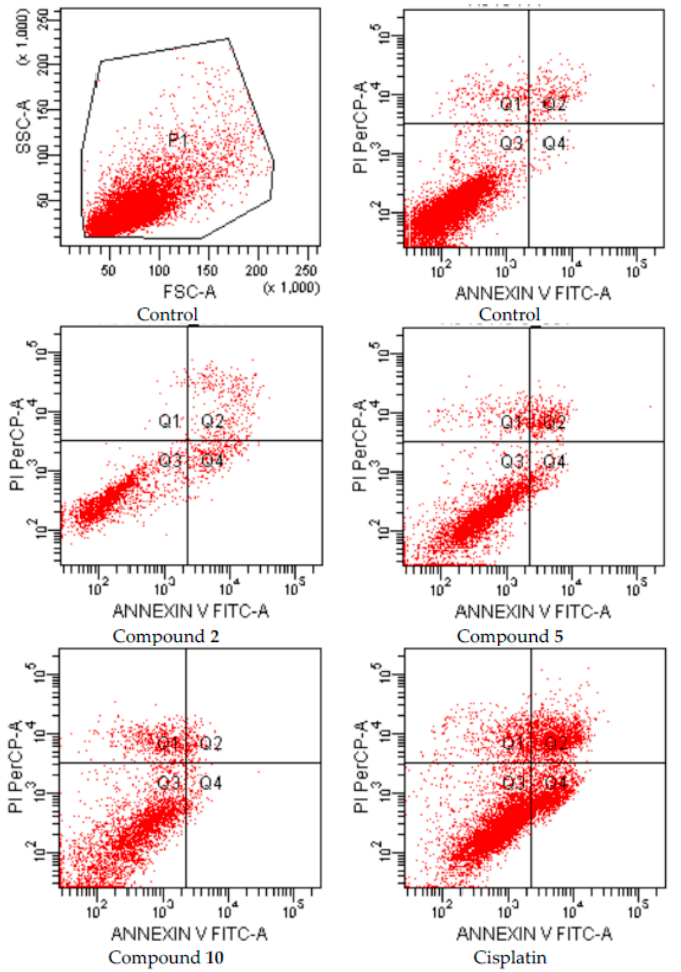
Figure 2. Flow cytometric analysis of A549 cells treated with IC 50 values of compounds 2 , 5 , 10 and cisplatin. A549 cells were cultured for 24 h in medium with IC 50 values of the compounds. At least 10,000 cells were analyzed per sample, and quadrant analysis was performed.